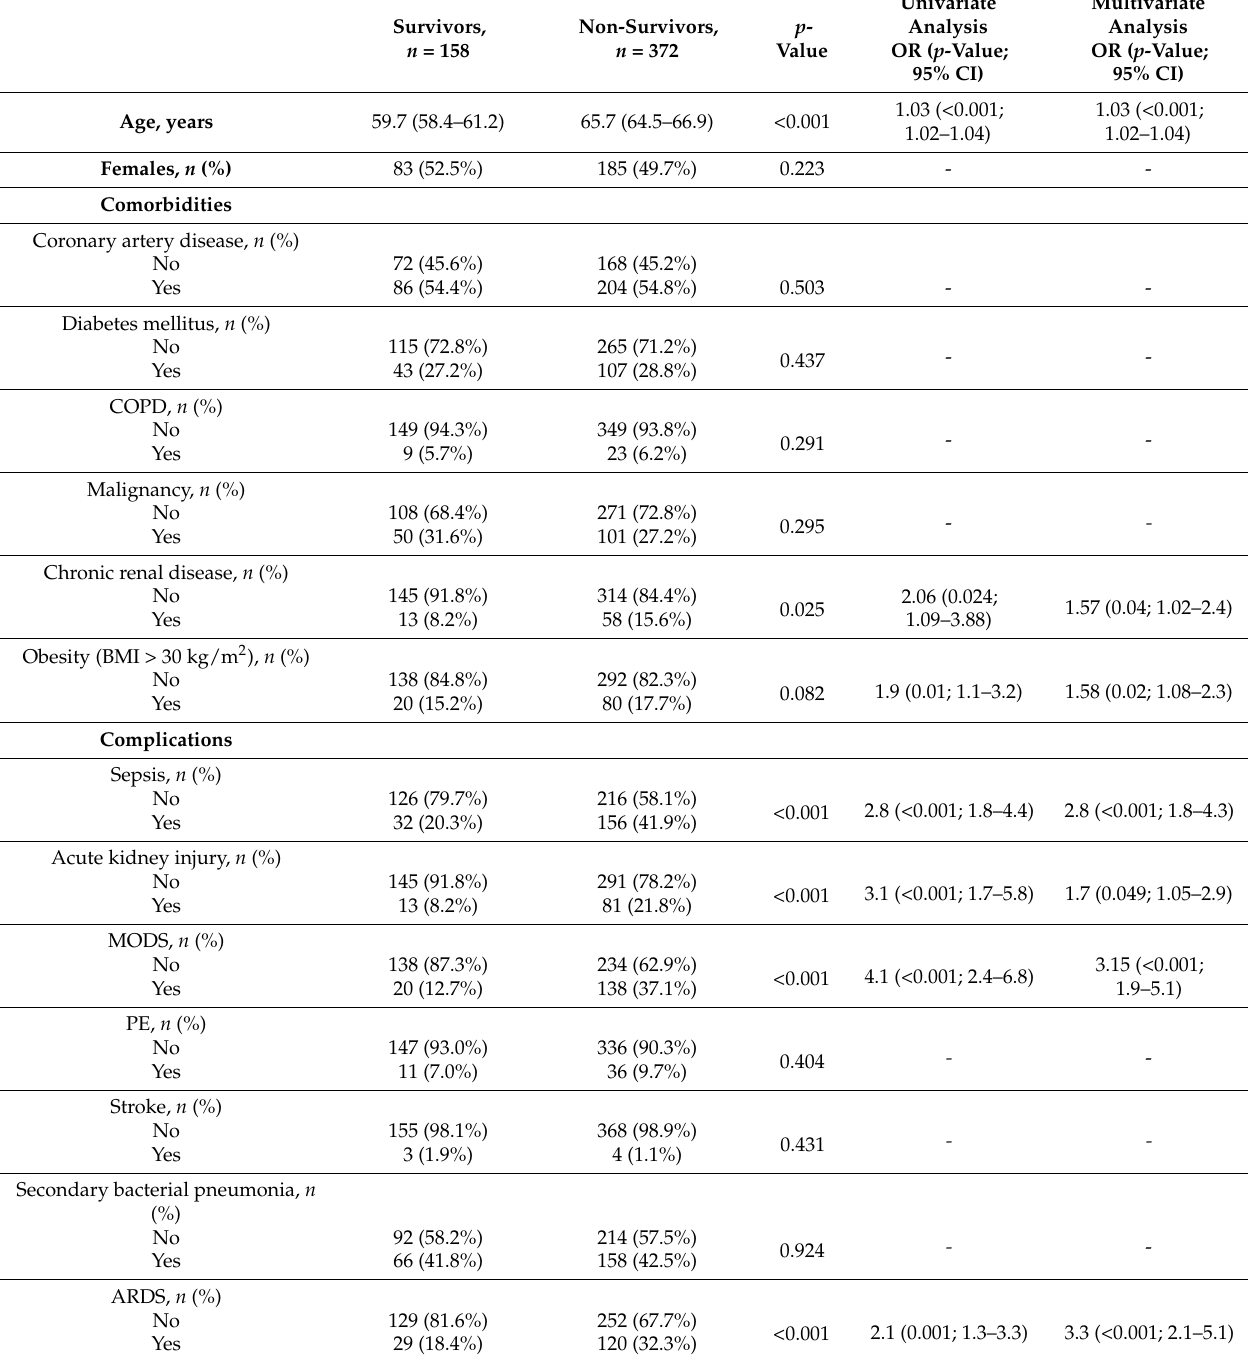
Table 3. Comparison between survivors and non-survivors. Data are presented as mean and 95% confidence intervals, median interquartile ranges, or numbers and percentages as appropriate. NIV (non-invasive ventilation); TT (invasive mechanical ventilation with tracheal tube); TS (invasive mechanical ventilation with tracheostomy); ICU (intensive care unit); MV (mechanical ventilation); ARDS (acute respiratory distress syndrome); PE (pulmonary embolism); OR (odds ratio); BMI (body mass index); CI (confidence interval); COPD (chronic obstructive pulmonary